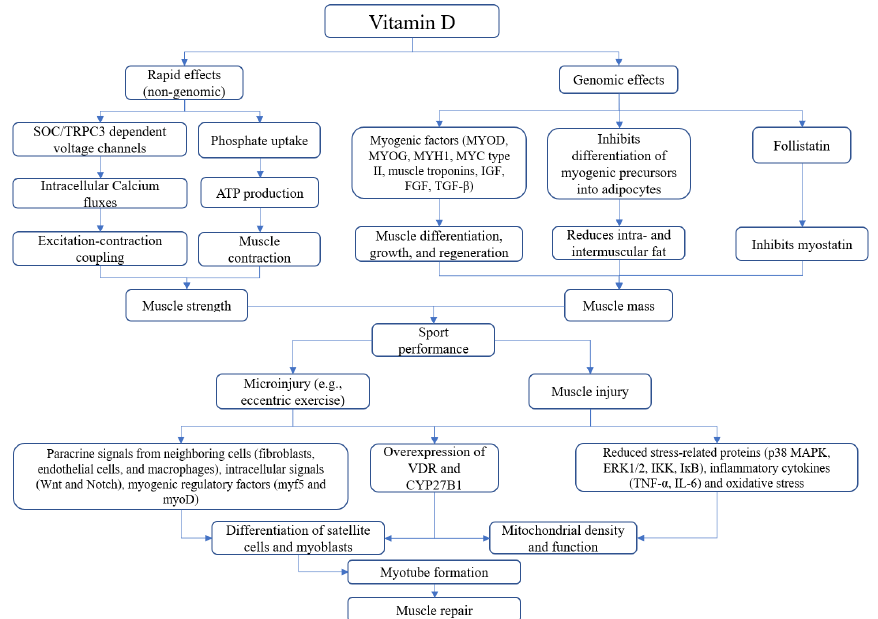
Figure 1. Vitamin D-mediated mechanisms affecting skeletal muscle performance and healing. Vitamin D produces non-genomic effects that affect calcium and phosphate uptake within muscle to sustain contraction, while long-term effects (genomic) of this hormone influence the release of myogenic factors and reduce the accumulation of fat tissue within muscle fibers as well as muscle catabolism. After direct or indirect muscle injury, three main events occur: paracrine signals by neighboring cells stimulate the release of myogenic mediators, overexpression of VDR and CYP27B1 and reduction of oxidative stress.